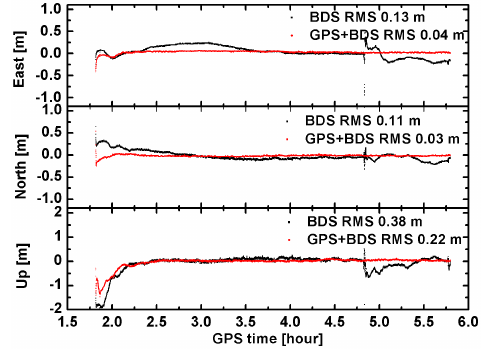
Figure 16. The positioning error time series of real-time dual-frequency PPP.